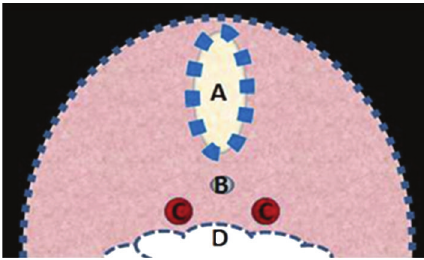
Figure 1: Depiction of a cross section through the early embryo demonstrating the relationship between the neural tube (A), noto- chord (B), dorsal aortae (C), and gut tube